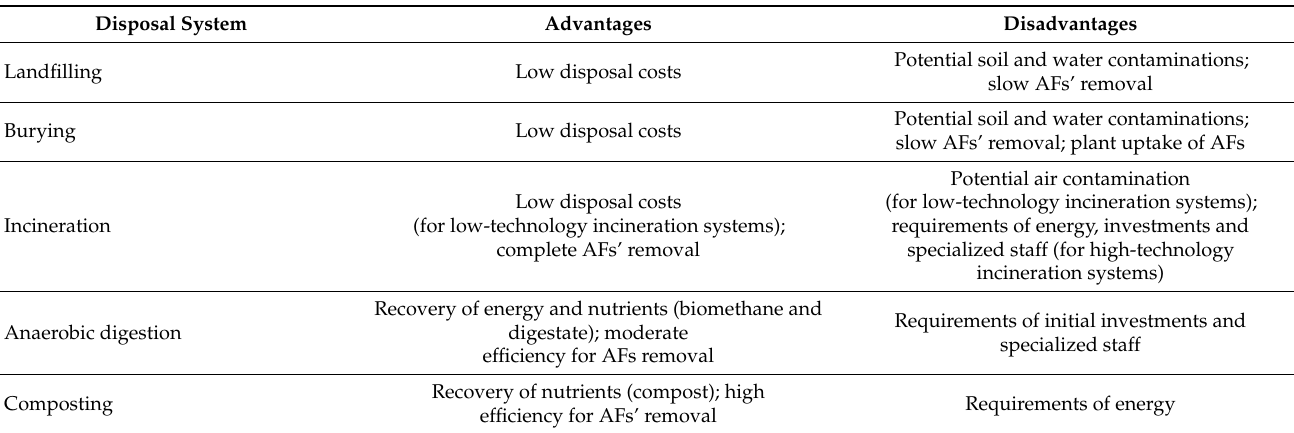
Table 2. Main advantages and disadvantages of different disposal systems for aflatoxin-contaminated food products. AFs: